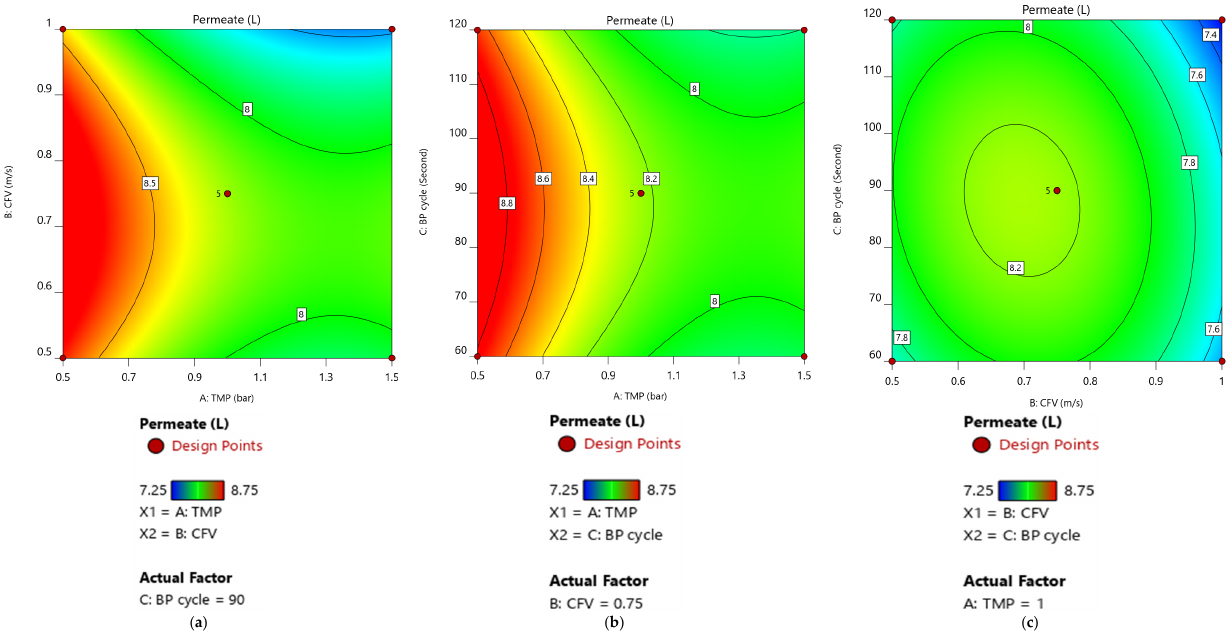
Figure 7. Response surface ‐ plot of membrane permeate volume as a function of the independent factors. ( a ) A: TMP and B: CFV at BP cycle= 90 sec. ( b ) A: TMP and C: BP cycle at CFV= 0.75 m/s. ( c ) B: CFV and C: BP cycle at TMP = 1 bar.